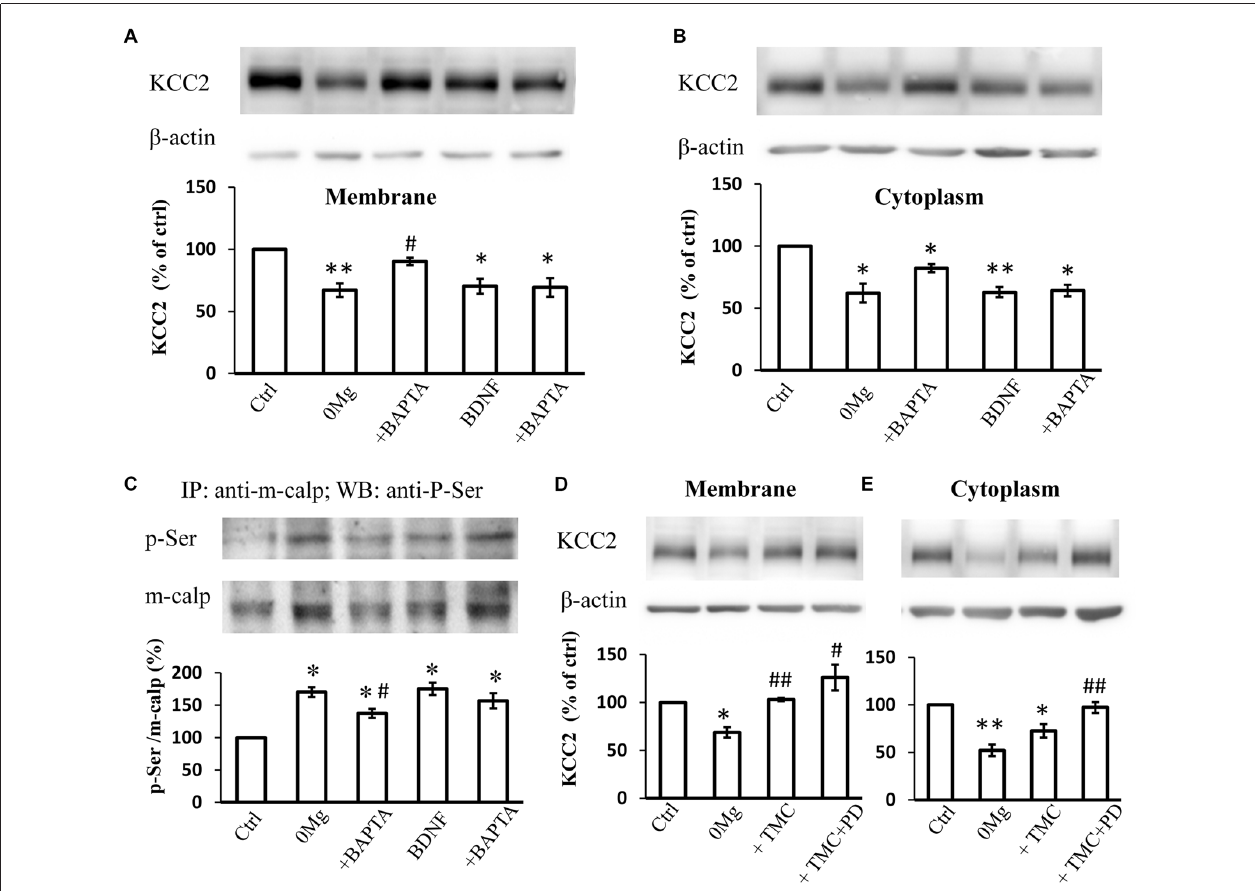
FIGURE 4 | The regulation of KCC2 by m-calpain is independent on [Ca 2 + ] i but is related to KCC2 endocytosis. (A) BAPTA is able to reverse 0 Mg 2 + induced mKCC2 down-regulation, but failed to reverse BDNF induced mKCC2 down-regulation. (B) BAPTA partially reverses the 0 Mg 2 + induced, but not BDNF induced Changes in cytoplasmic KCC2 (cKCC2) down-regulation. (C) Phosphor-serine level of m-calpain from 0 Mg 2 + , 0 Mg 2 + + BAPTA, BDNF and BDNF + BAPTA treated slices. BAPTA intervention partially reverses the 0 Mg 2 + induced, but not BDNF induced the increase of phosphor-serine level of m-calpain. (D–E) Tautomycetin (TMC) can reverse KCC2 down-regulation in plasm membrane (left), but the expression of KCC2 in cytoplasm remained significantly lower than DMSO group (right). In TMC + PD98059 co-treated group the expression of KCC2 is rescued to control level. ∗ p < 0.05, ∗∗ p < 0.01 compared with Ctrl group; # p < 0.05, ## p < 0.01 compared with either 0 Mg 2 +